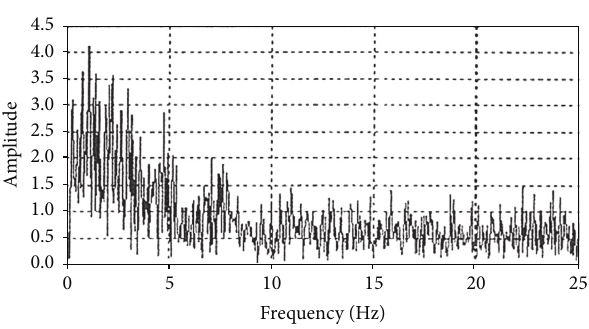
Figure 6: Frequency content in accordance with the design